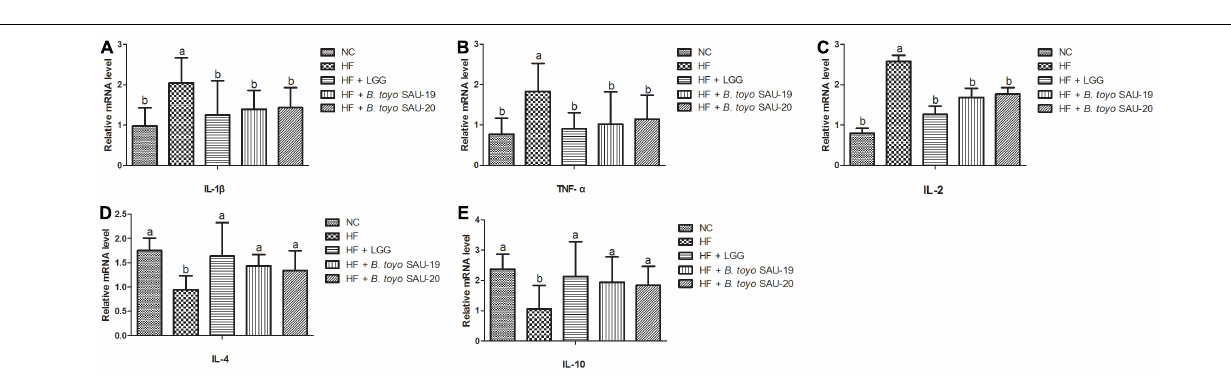
FIGURE 6 | Effects of Bacillus toyonensis SAU-19 and SAU-20 on relative mRNA expressions of pro- and anti-inflammation related cytokines in the small intestine tissue of mice fed high fat diet (A–C) mRNA expressions of pro-inflammatory cytokines (D,E) mRNA expressions of anti-inflammatory cytokines. Bars represent means ± standard deviation (SD). The values are presented as the mean ± SD. Bars without the same letter differed significantly ( n = 6, P < 0.05). NC, mice were administered normal diet + normal saline; HF, mice were fed high fat diet + normal saline; HF + LGG, mice were administered high fat diet + 10 6 Lactobacillus rhamnosus GG; HF + B. toyo. SAU-19, mice were administered high fat diet + 10 6 Bacillus toyonensis SAU-19 from A. adenophora ; HF + B. toyo. SAU-20, mice were administrated with high fat diet + 10 6 Bacillus toyonensis SAU-20 from A. adenophora